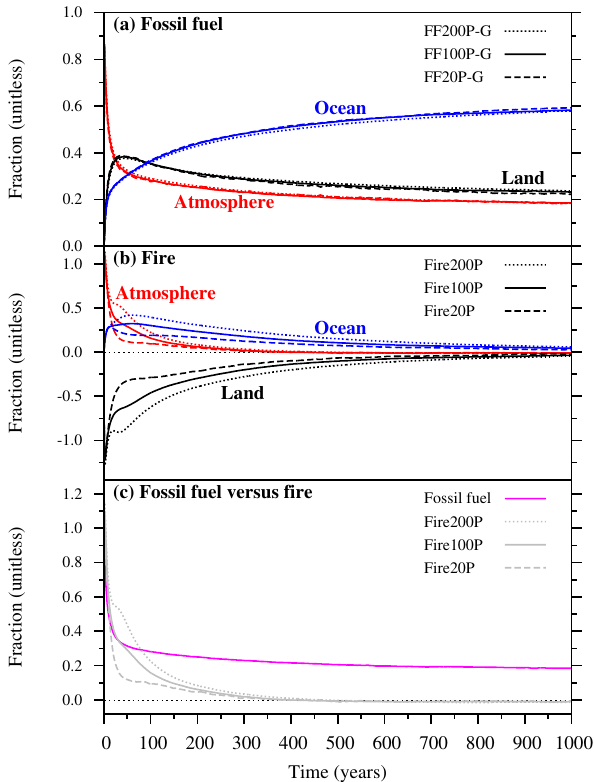
Figure 3. Changes in global carbon stocks resulting from the pulse experiments, expressed as fractions of each pulse magnitude. (a) Fossil fuel pulses, which were set equal to gross fire emissions. (b) Fire pulses. The fractions were sometimes greater than 1.0 for the atmosphere and land, because pulses were defined based on direct combustion only. (c) Results for atmospheric carbon only (i.e., air- borne fraction); for fossil fuel, only FF100P-G is illustrated as the results were almost equal for the FF20P-G and FF200P-G cases (see panel a ).